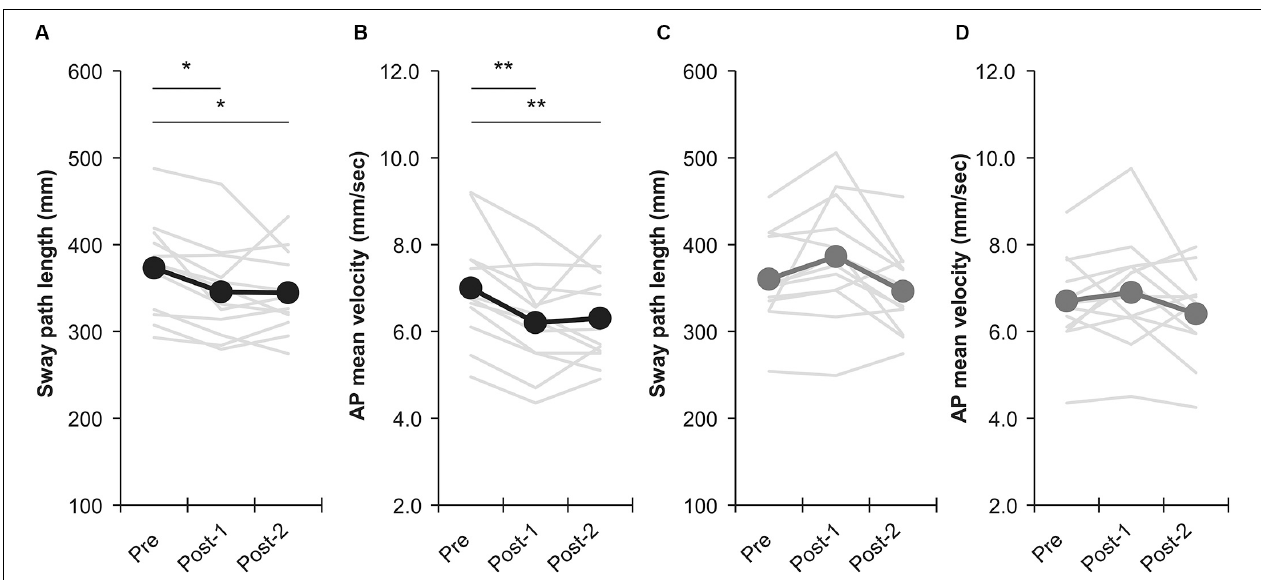
FIGURE 3 | Effects of intervention in the nGVS condition and nGVS + foam rubber condition. (A) Sway path length of nGVS condition. (B) AP mean velocity of nGVS condition. (C) Sway path length of nGVS + foam rubber condition. (D) AP mean velocity of nGVS + foam rubber condition. Error bars indicate SE. * p < 0.05, ** p <